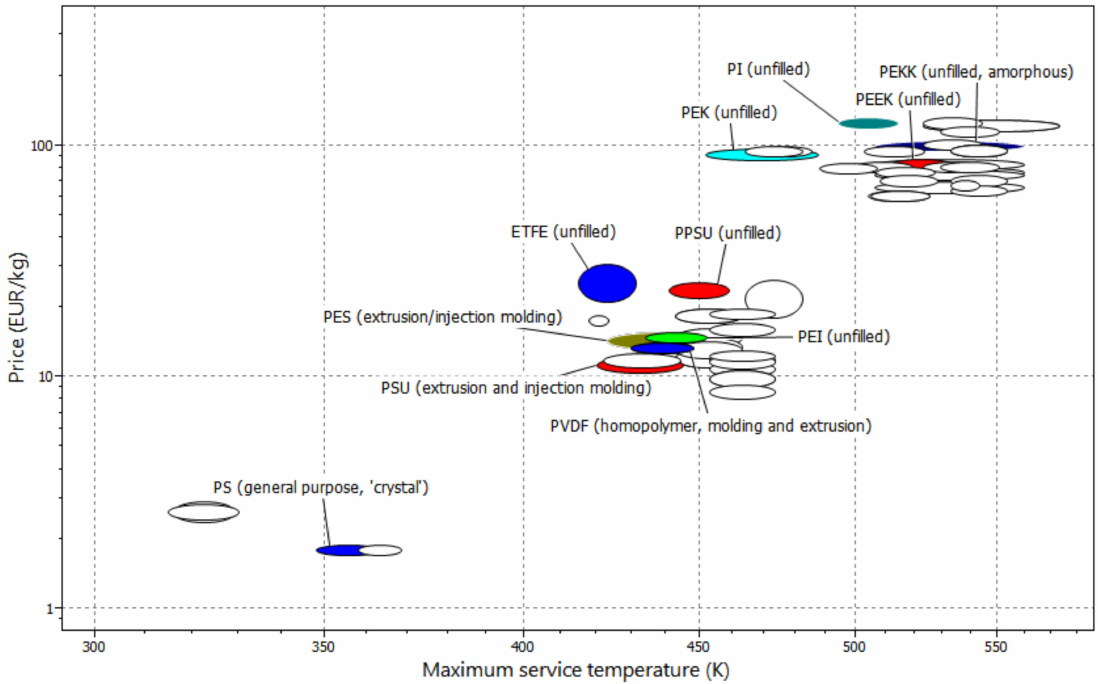
Figure 16. Commercial polymer products: specific costs and maximum service temperature